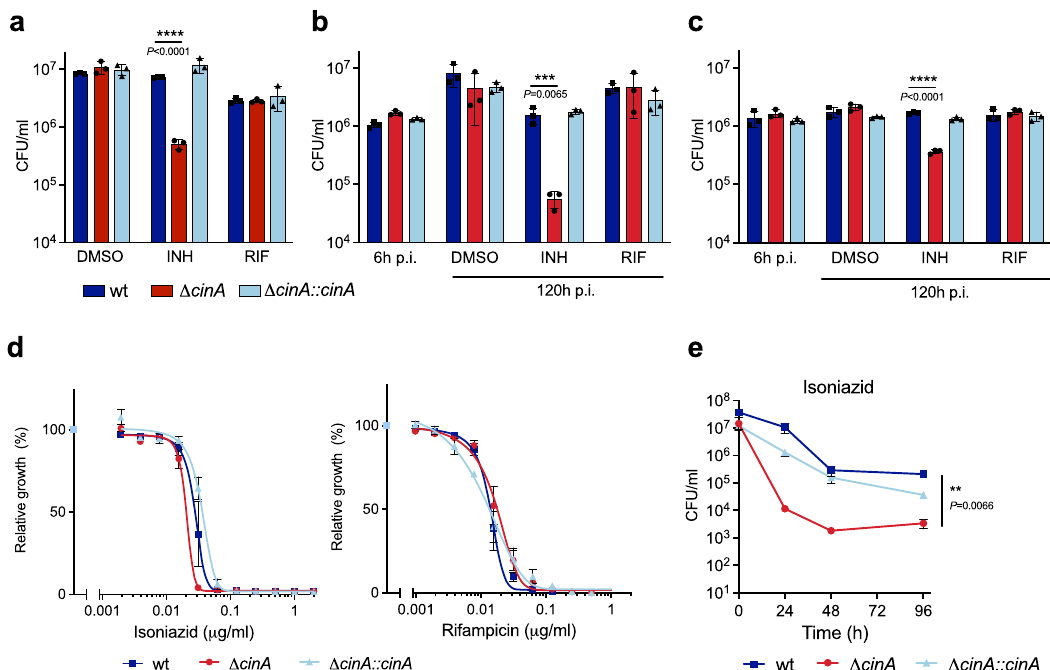
Fig. 1 CinA mediates intrinsic isoniazid tolerance. a Bacteria were starved in PBS for 14 days and then exposed to isoniazid (INH, 0.5 µ g/ml),